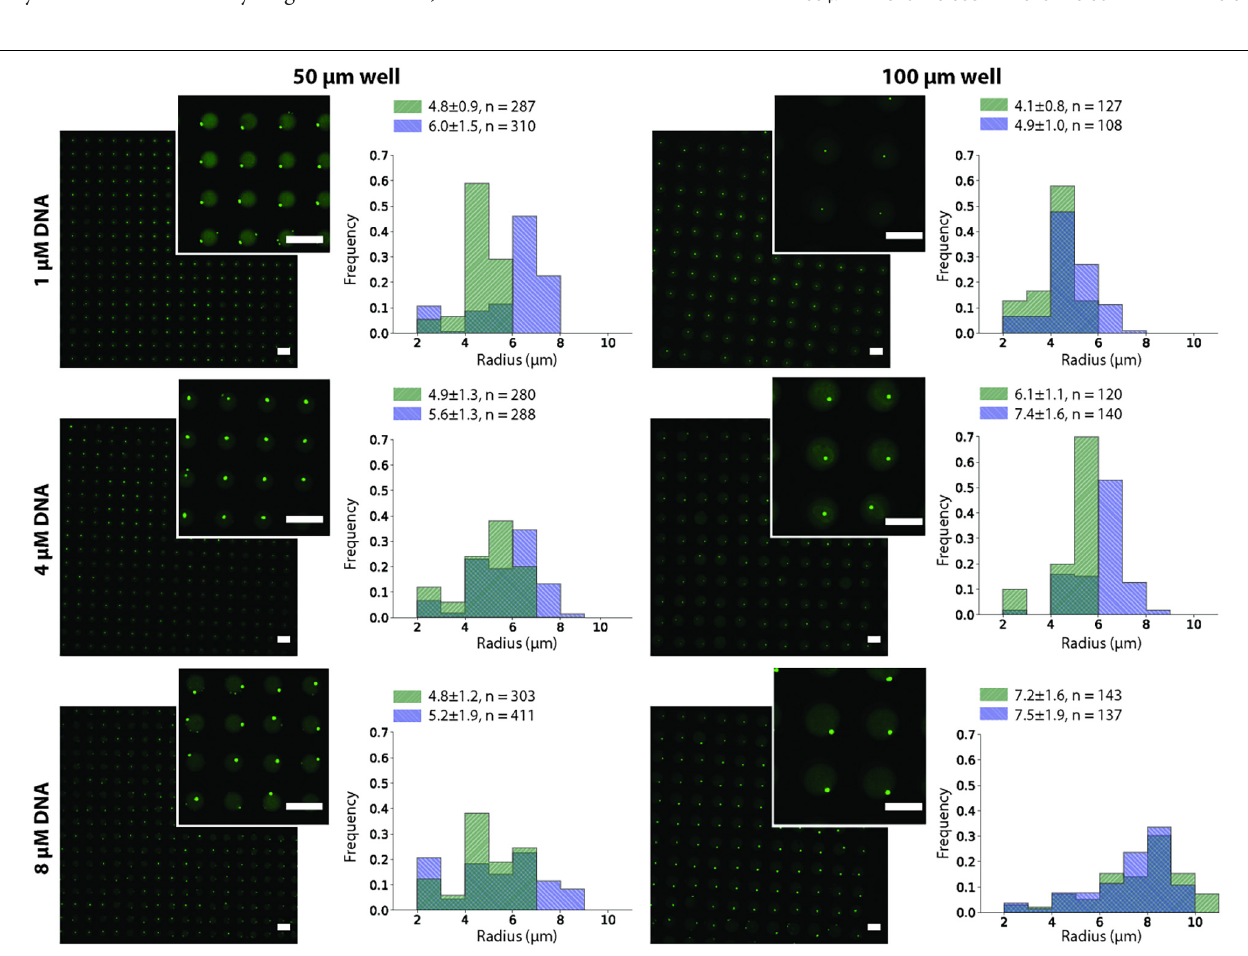
FIGURE 4 | DNA hydrogel particles in Dex/PEG microdroplet array stained by Oligreen in 50- and 100- µ m microwells, displaying their size distribution at different DNA concentrations for two separate experiments after two annealing rounds. Labels indicate the average, standard deviation, and size of each sample. Scale bars = 100 µ